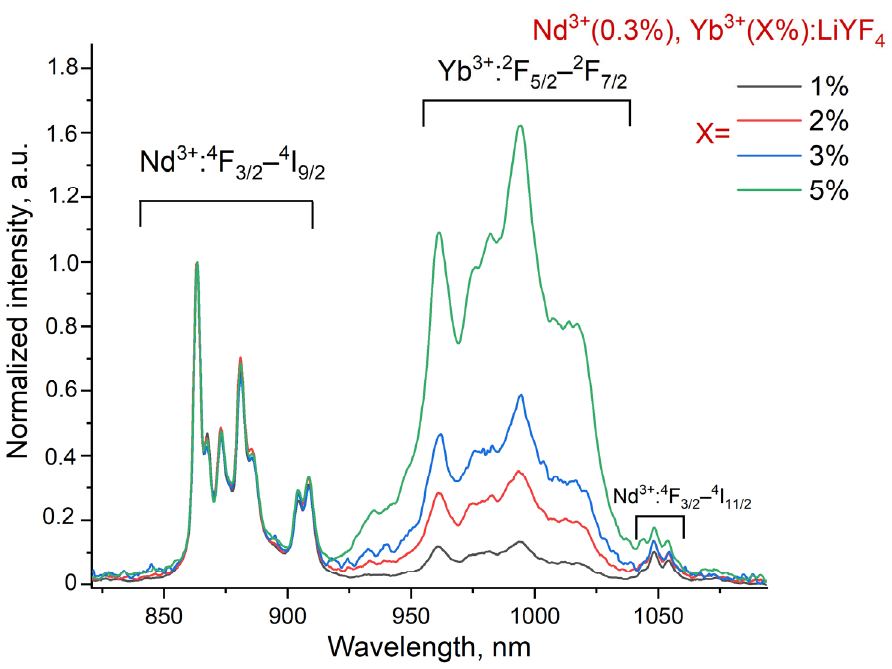
Figure 4. Normalized luminescence spectra of Nd 3+ (0.3%), Yb 3+ (1.0, 2.0, 3.0, and 5.0%):LiYF 4 phosphors recorded at room temperature. The excitation λ ex = 520 nm corresponds to 4 I 9/2 – 2 K 13/2 / 2 G 9/2 of Nd 3+ absorption band. The spectra are normalized at ~861 nm peak of Nd 3+ .